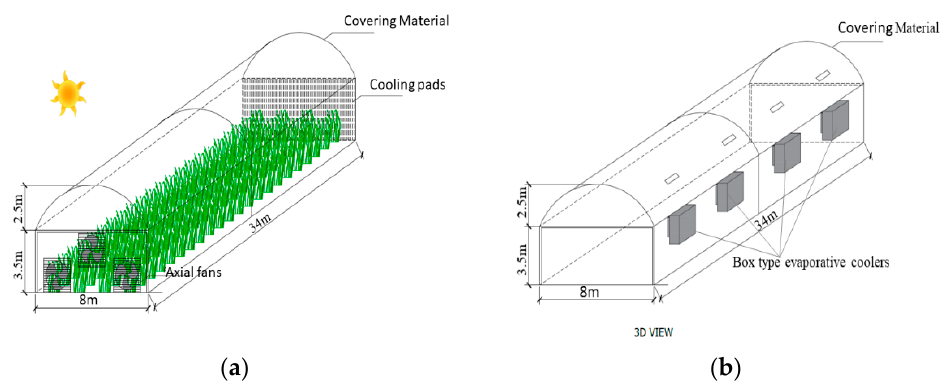
Figure 1. ( a ) Conventional evaporative coolers and ( b ) box type evaporative